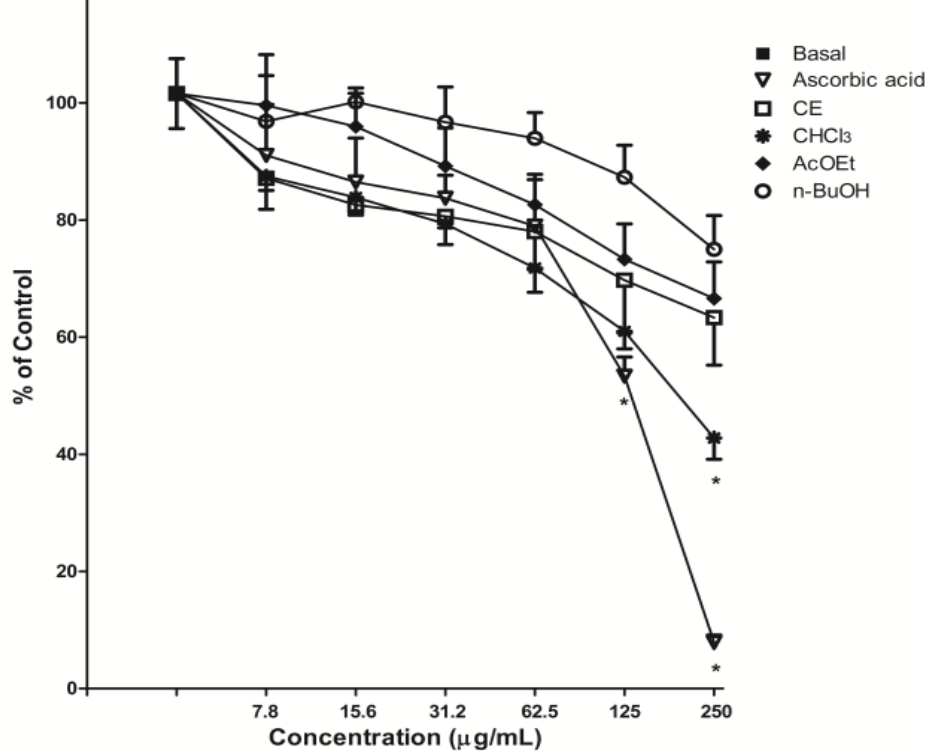
Figure 2. Effect of S. guaraniticum CE and fractions on scavenging of ROS in supernatant of rat brain homogenate, by DCFH-DA